Question: What form of chart is displayed?
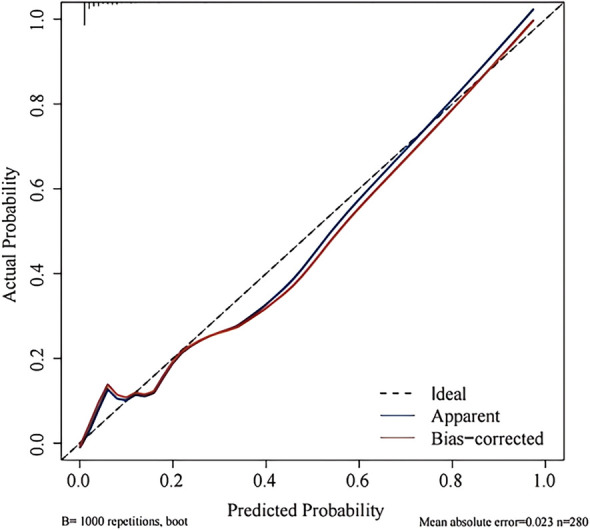
Answer: line